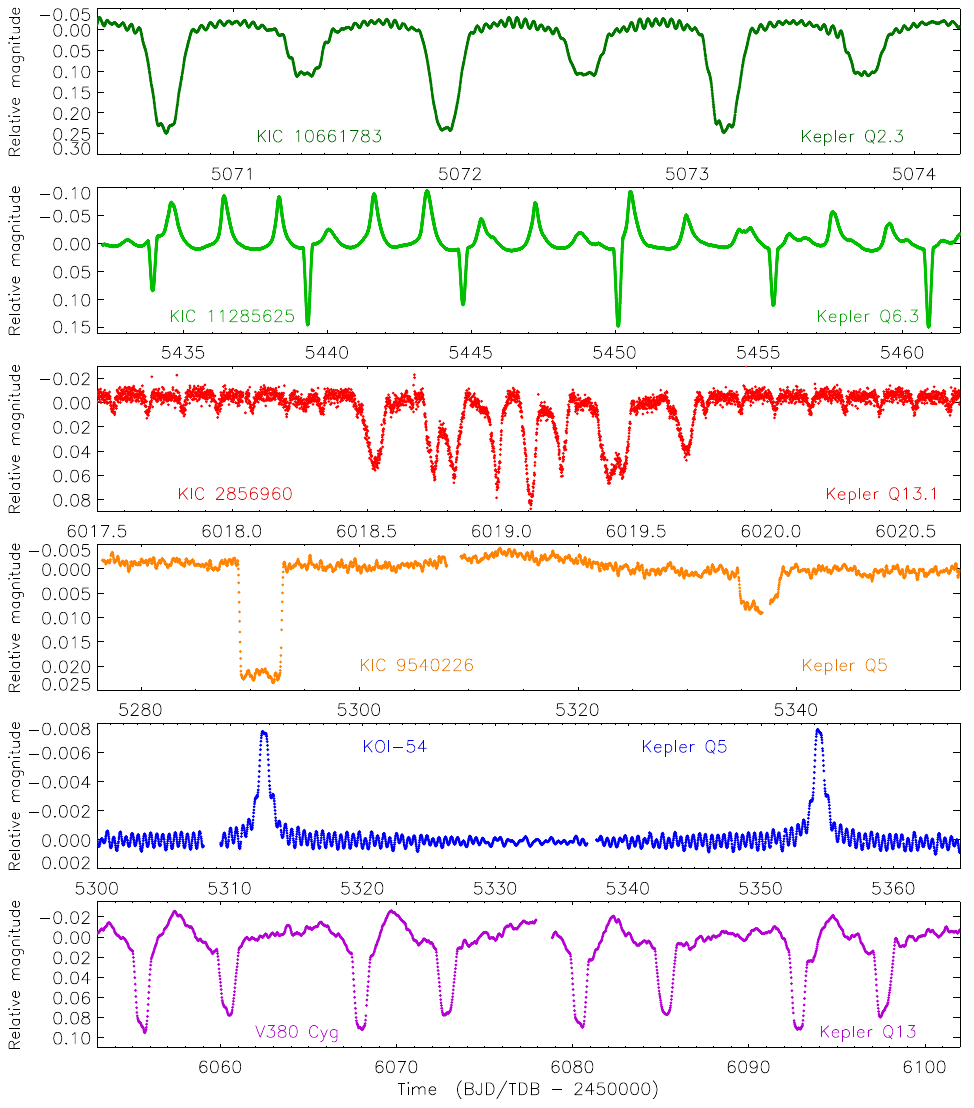
Figure 6. Example Kepler satellite light curves of a set of binary systems. The names and the Kepler quarters are